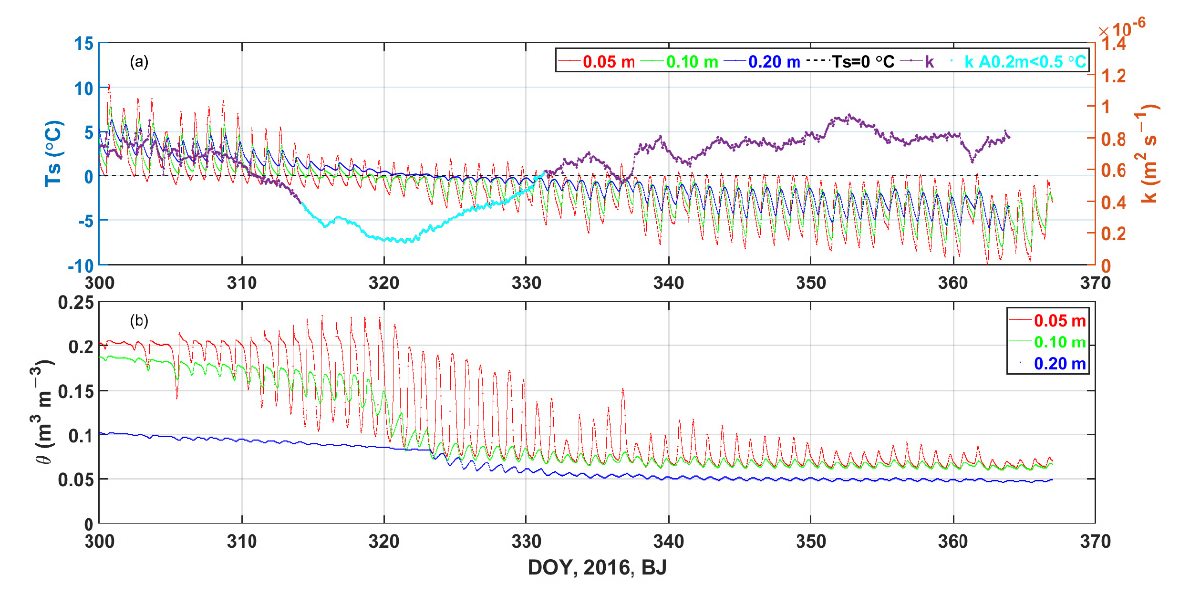
Figure 9. The ( a ) soil temperature (Ts, °C) at the depths of 0.05 m, 0.10 m and 0.20 m, and soil apparent thermal diffusivity (k, m 2 s − 1 ), and ( b ) soil moisture ( θ , m 3 m − 3 ) at the depths of 0.05 m, 0.10 m and 0.20 m over DOYs 300–365, 2016, at BJ. The labels of k are marked in cyan when the soil amplitude at the 0.2 m depth is less than 0.5 °C.